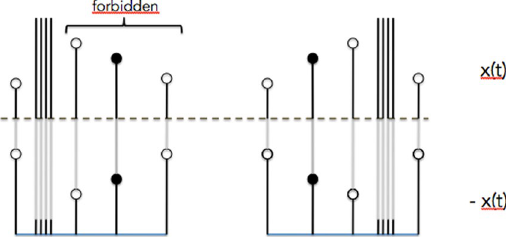
Figure 9. Schematic representation of the two sets of diagrams contributing to P bot (3) (which is equivalent to P top (3) as computed on − x ( t )). In every case the reference node x 0 is highlighted as black solid dot. Hidden nodes (an arbitrary large amount of them) are schematized as vertical bars with no dots on top. The first diagram (bottom, left) does not actually appear in { − x ( t )} as the associated diagram in the original series is forbidden (in the fully chaotic logistic map we never find three consecutive data points in decreasing order 18 ). Accordingly, the only set of diagrams is the one pictorically represented in the bottom right. The relative ordering of the data in the original chaotic time series is represented in the upper